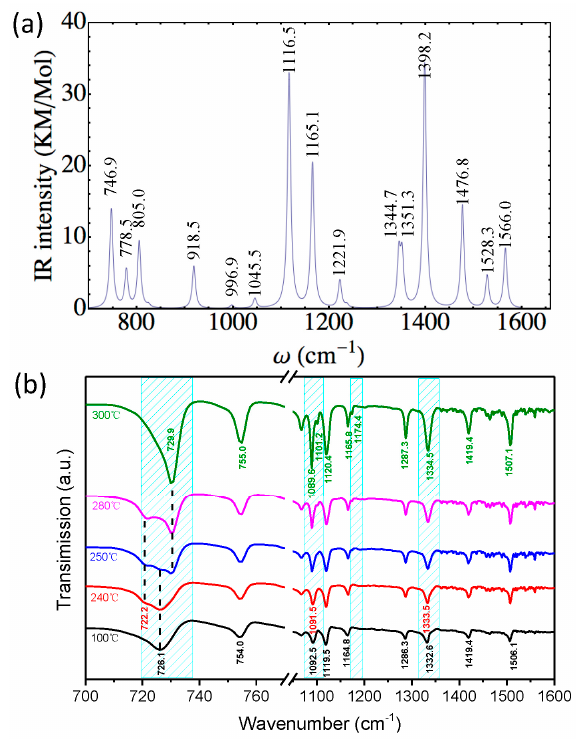
Figure 7. ( a ) Calculated CuPc single molecule vibrational modes by using density-functional theory; and ( b ) FTIR spectra of CuPc crystals annealed at different temperatures.